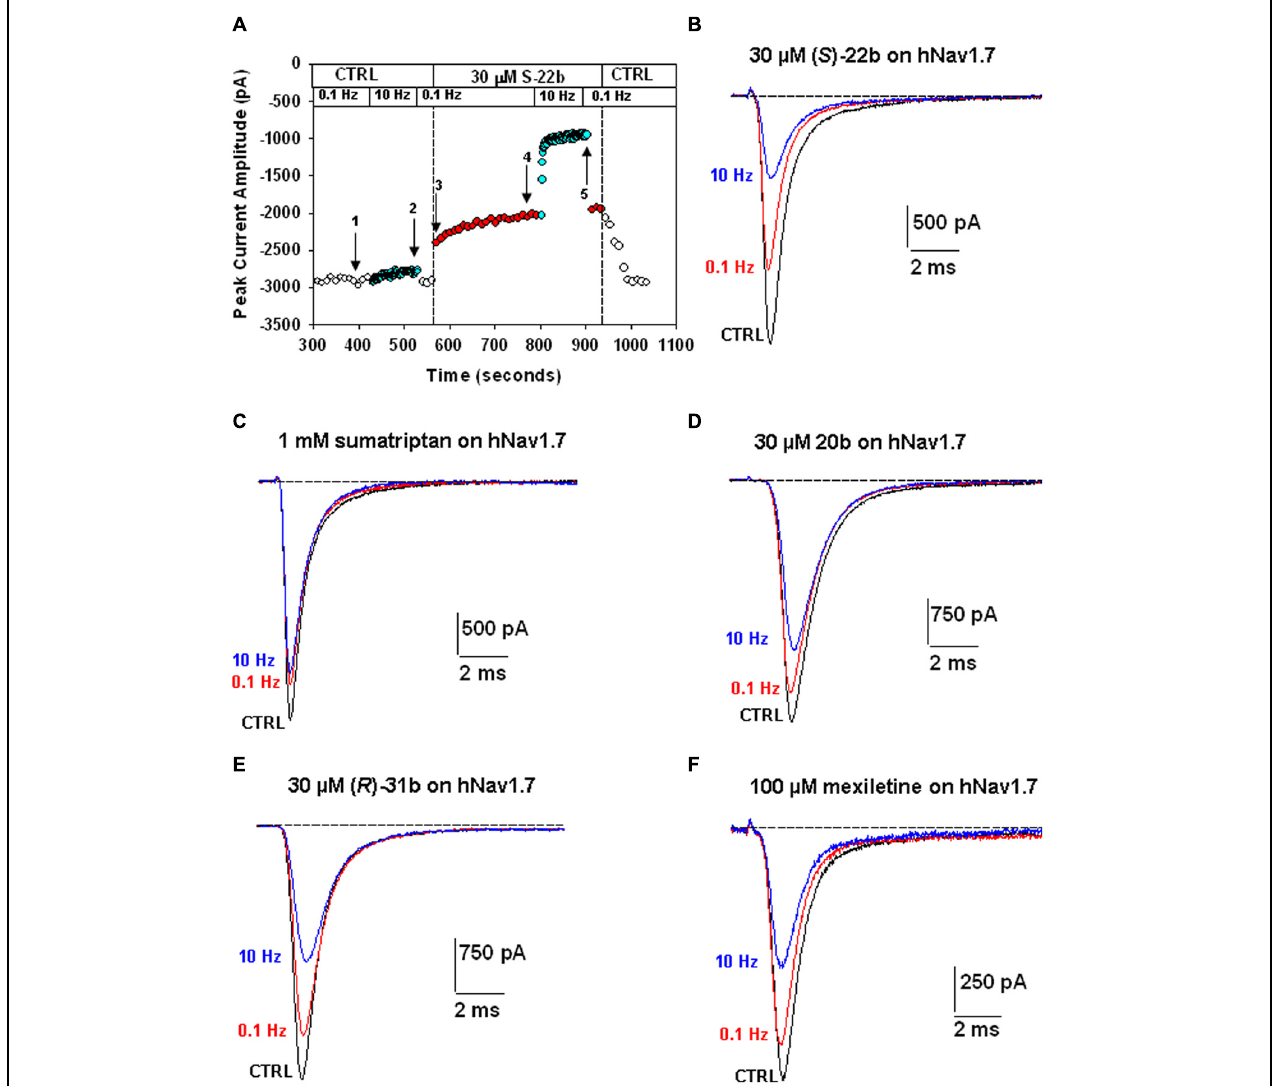
FIGURE 2 | Effects of exploratory compounds on hNav1.7 channels at 0.1 Hz and 10 Hz, to determine tonic and phasic block, respectively. (A) Time course of peak sodium current amplitude in a representative HEK293 cell permanently transfected with hNav1.7, before and during application of 30 µ M ( S )-22b, and after drug washout. The membrane was held at –120 mV and depolarized to –30 mV for 25 ms at 0.1 or 10 Hz stimulation frequency. The numbered arrows correspond to effects described